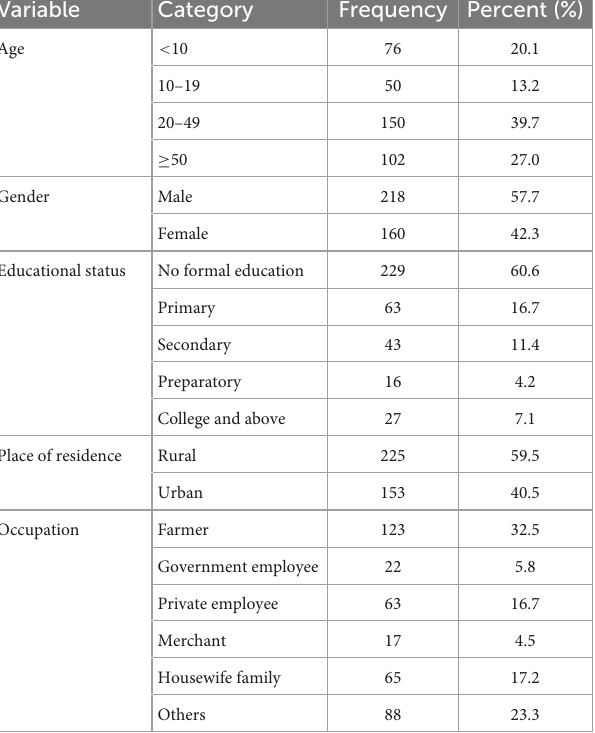
TABLE 1 Socio-demographic characteristics of participants scheduled for elective surgical procedures in public hospitals in Harari regional state, Eastern Ethiopia, 2021 ( n =